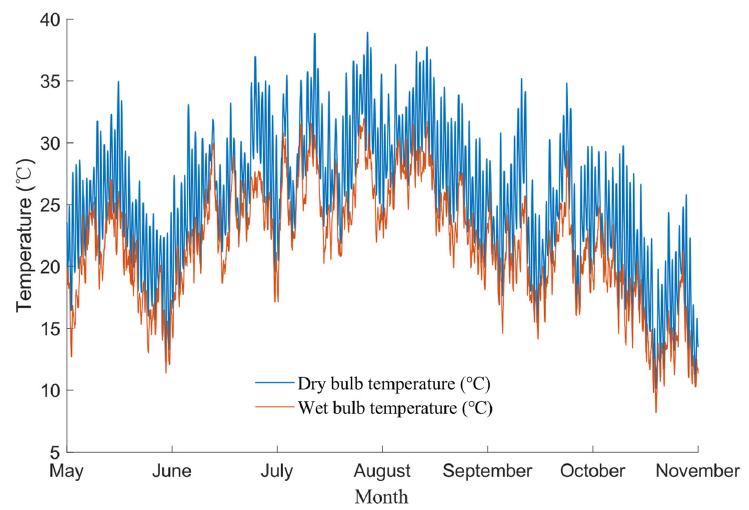
Figure 3. Outdoor temperature in Wuhan during the cooling period.